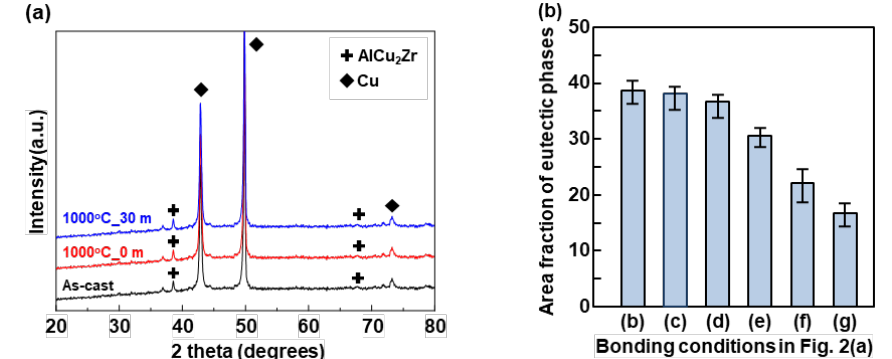
Figure 5. ( a ) X-ray diffraction patterns of as-cast brazing alloy and brazed seam at 1000 °C for 0 and 30 min, respectively and ( b ) the area fraction of the AlCu 2 Zr phases in brazed seam at the different bonding conditions shown in Figure 2.